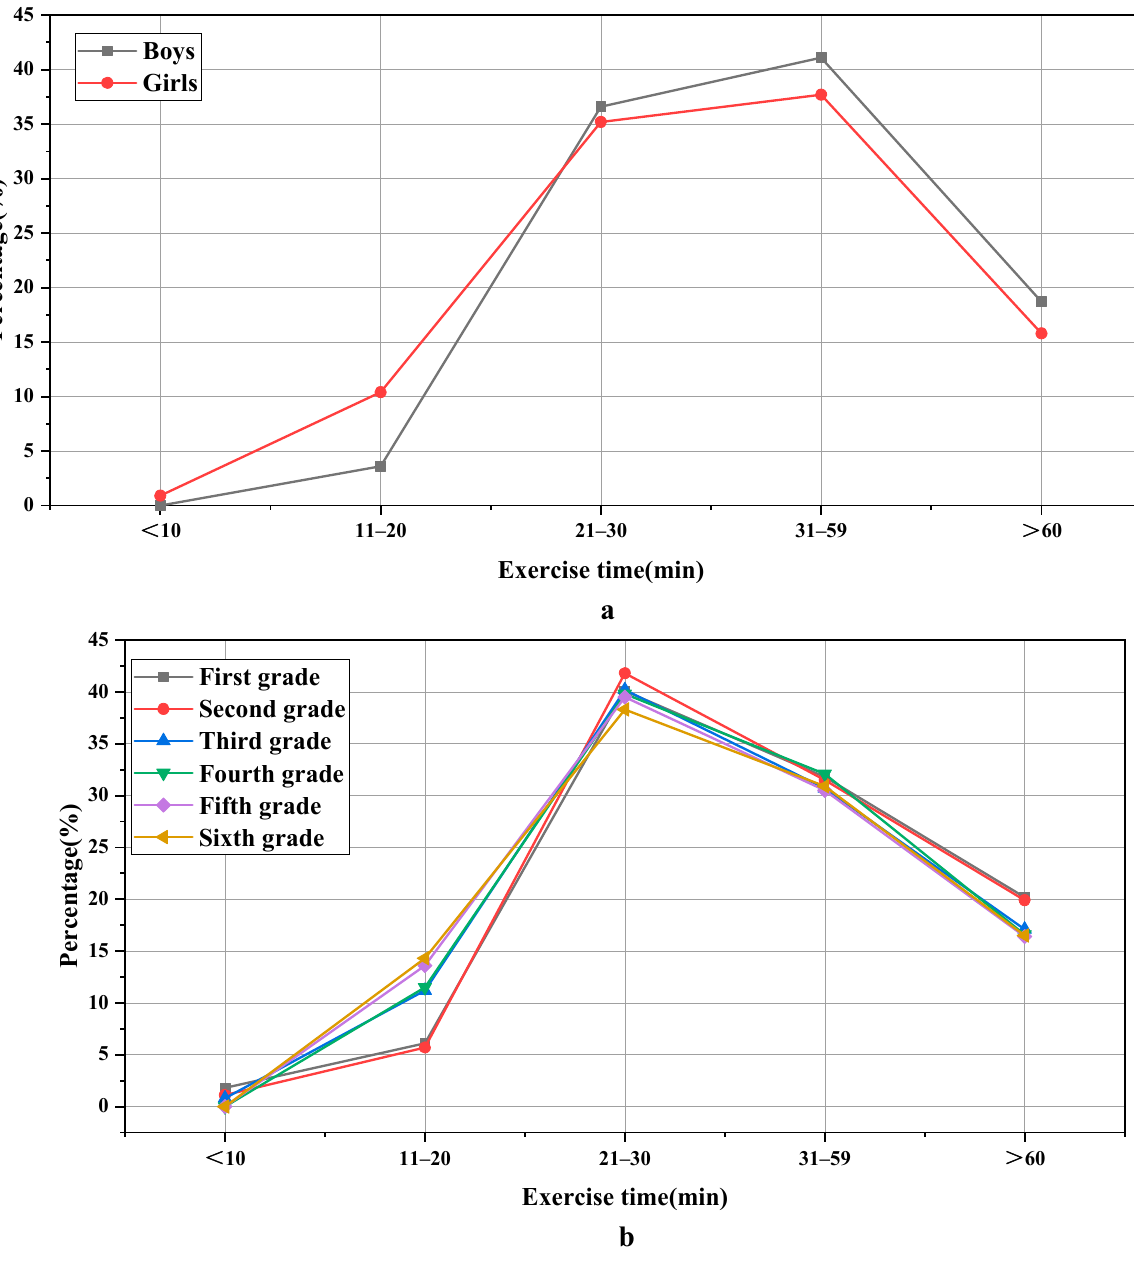
Figure 2. Statistical results of exercise time: ( a ) stands for the gender classification of the sample; ( b ) stands for the grade classification of the sample.